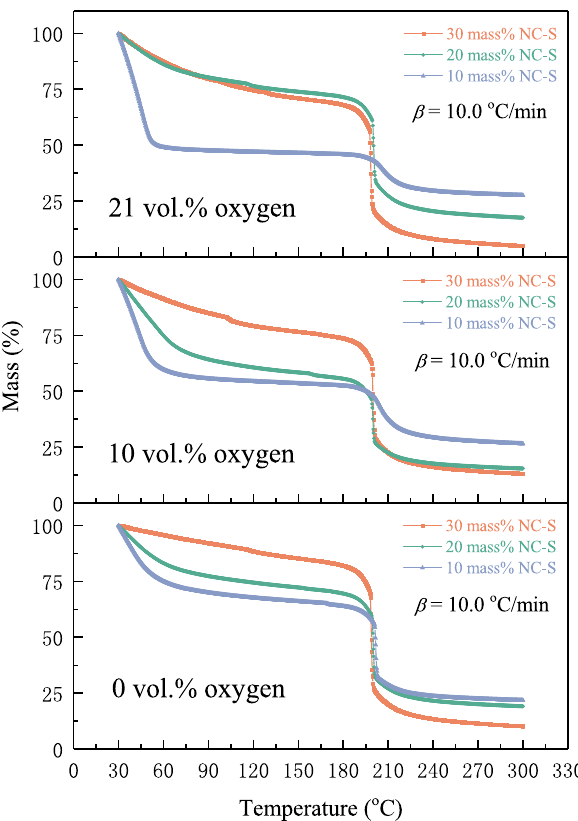
Figure 2. Comparison of TG curves of NC-S with different concentrations in different atmosphere conditions.